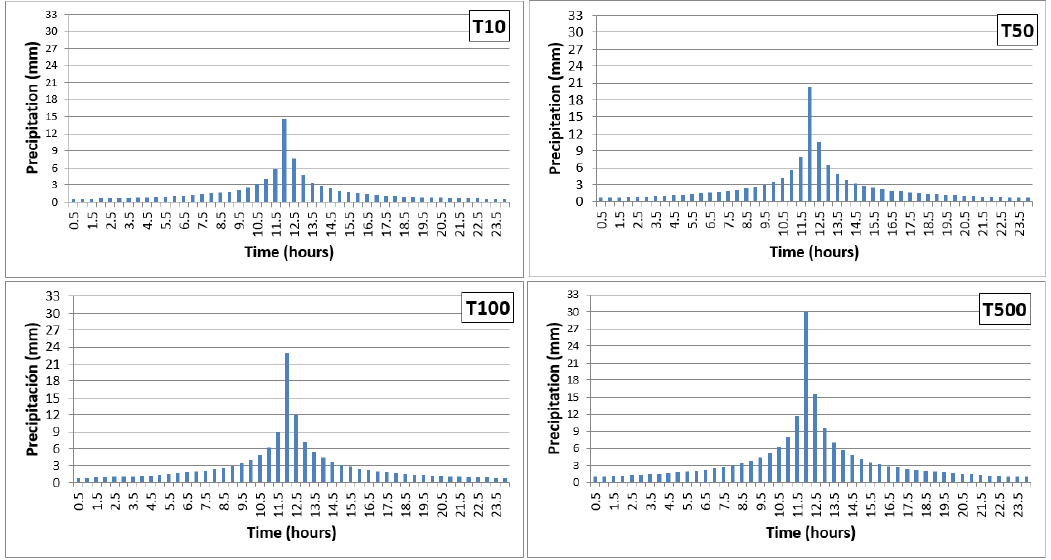
Figure 7. Synthetic hyetographs for return periods of 10, 50, 100, and 500 years.